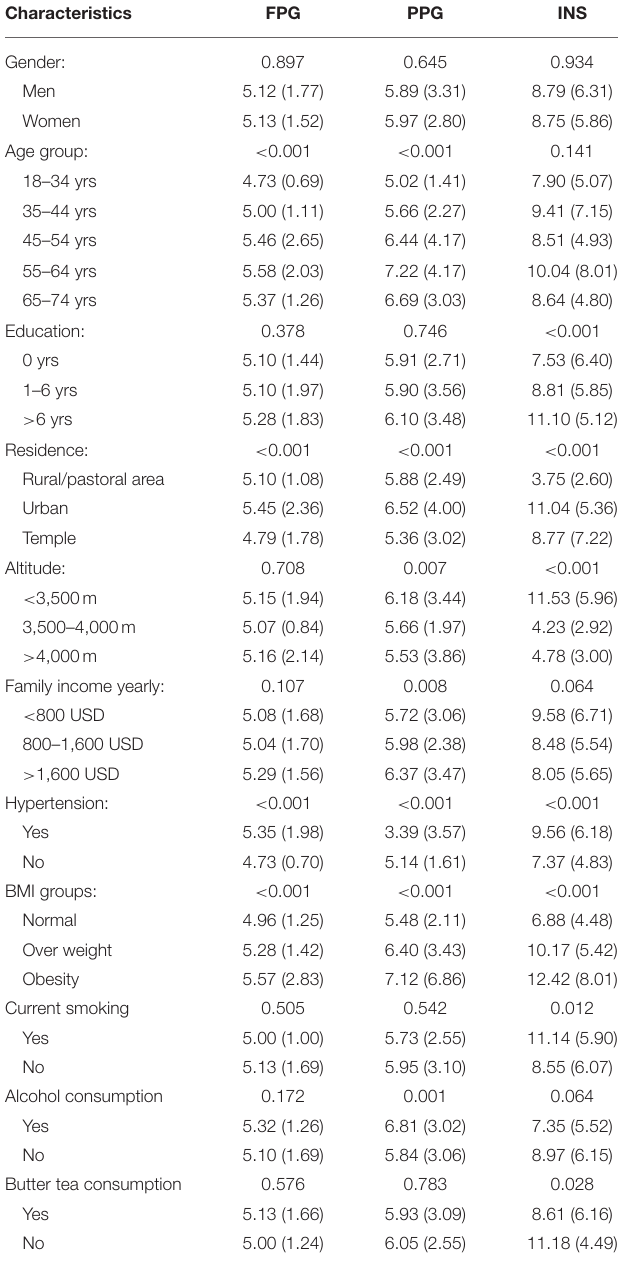
TABLE 2 | Levels of blood glucose in the different groups by